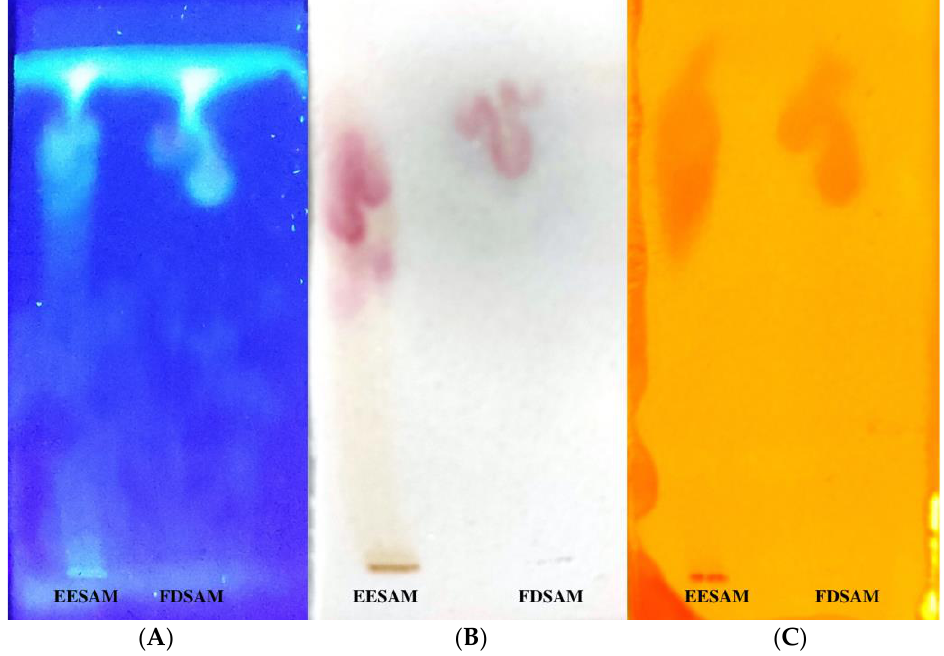
Figure 1. TLC chromatographic profile of the extract and fraction of A. muricata . EESAM — ethanolic extract from seeds; FDSAM — Dichlomethane fraction from seeds. Mobile phase: Ethyl acetate: Methanol (9:1). Developers: ( A ) — 365 nm ultraviolet light; ( B ) — Kedde; ( C ) — Dragendorff. Source: authors.